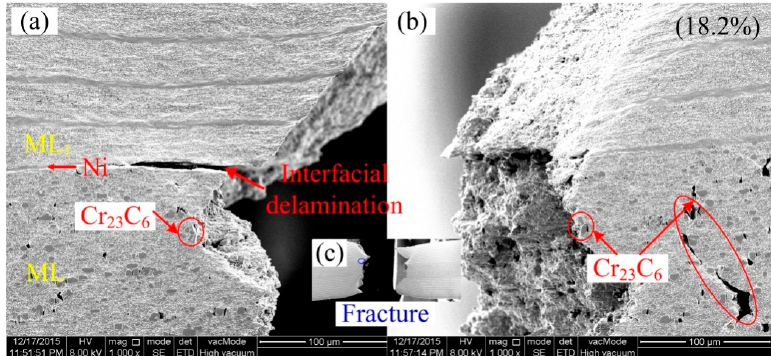
Figure 10. Fracture surfaces of multilayered steel (MLS) in-situ tensile specimen ( a ) one fracture surface, ( b ) matched fracture surface.